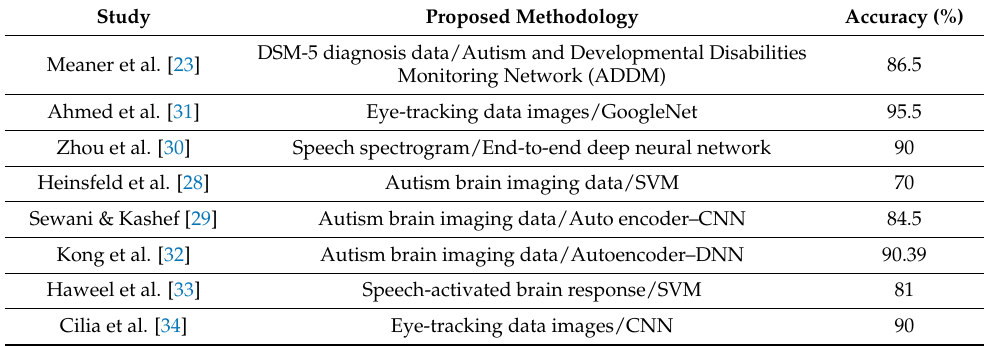
Table 1. Previous studies on computerized ASD diagnosis.